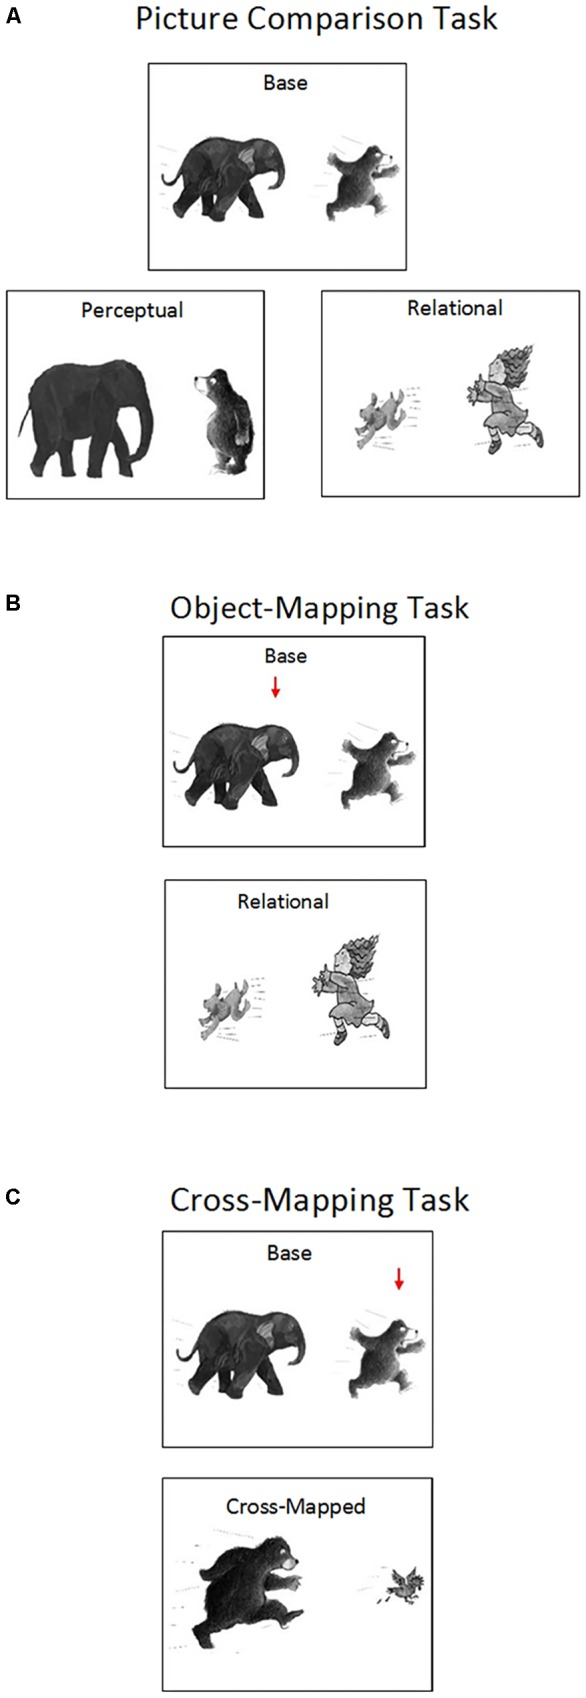
Examples of Areas of Interest (AOIs) and saccade paths in the Picture Comparison Task (A), the Object-Mapping Task (B), and the Cross-Mapping Task (C).